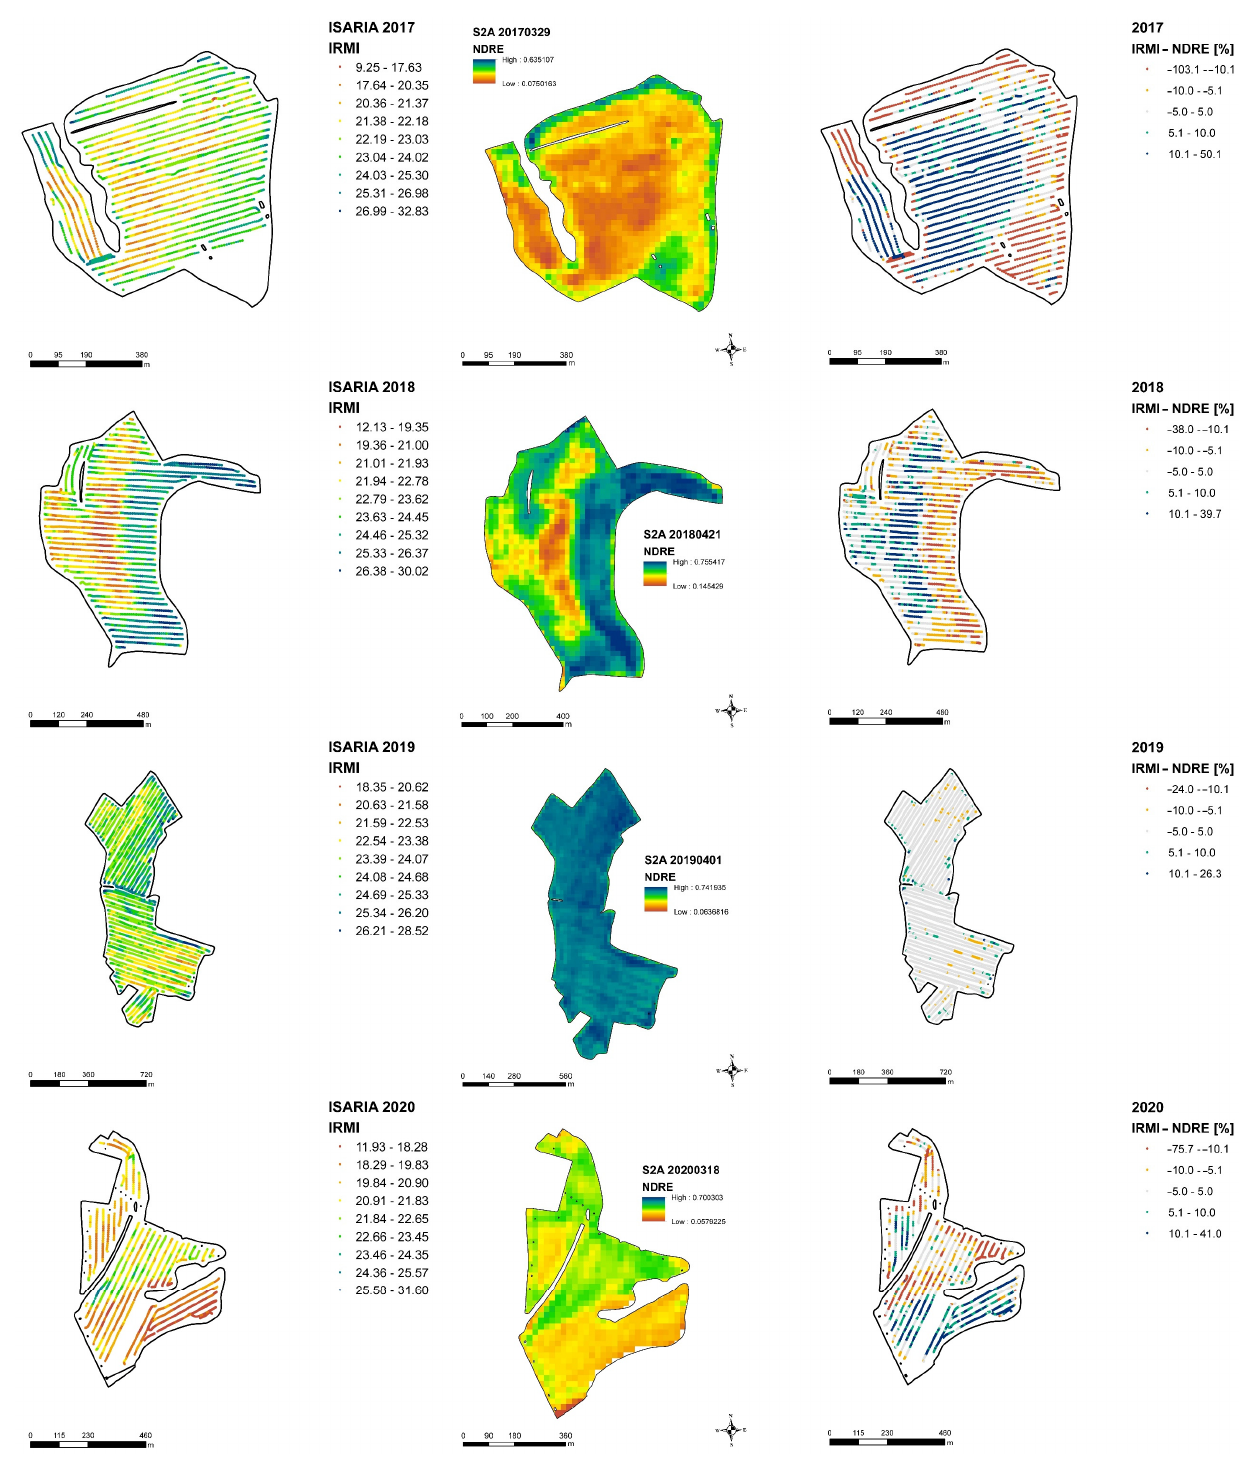
Figure 8. Example of the comparison of four experimental fields in the selected years: vegetation index ISARIA IRMI ( left ); vegetation index Sentinel-2 ( middle ); relative (%) comparison of differences between the two sensing systems ( right